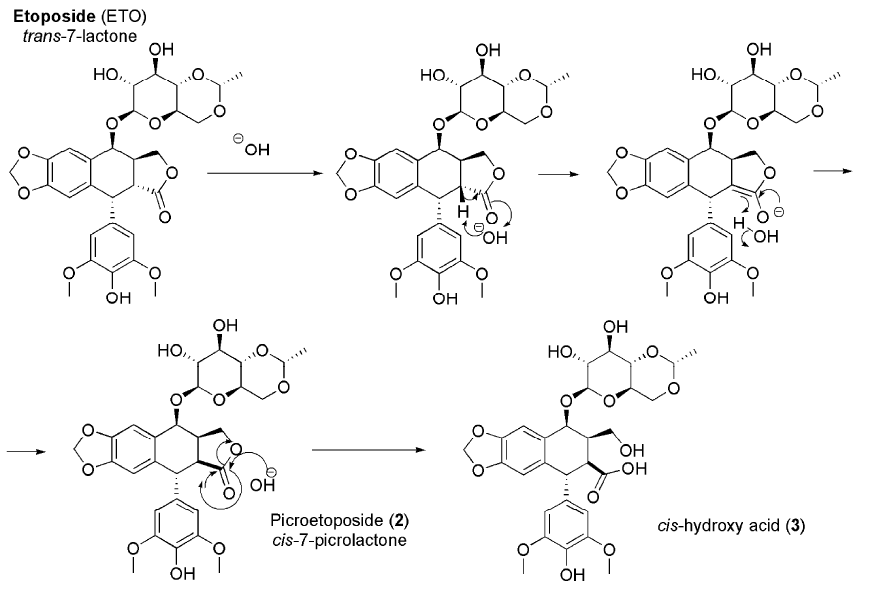
Figure 3. Mechanism of epimerization of ETO.